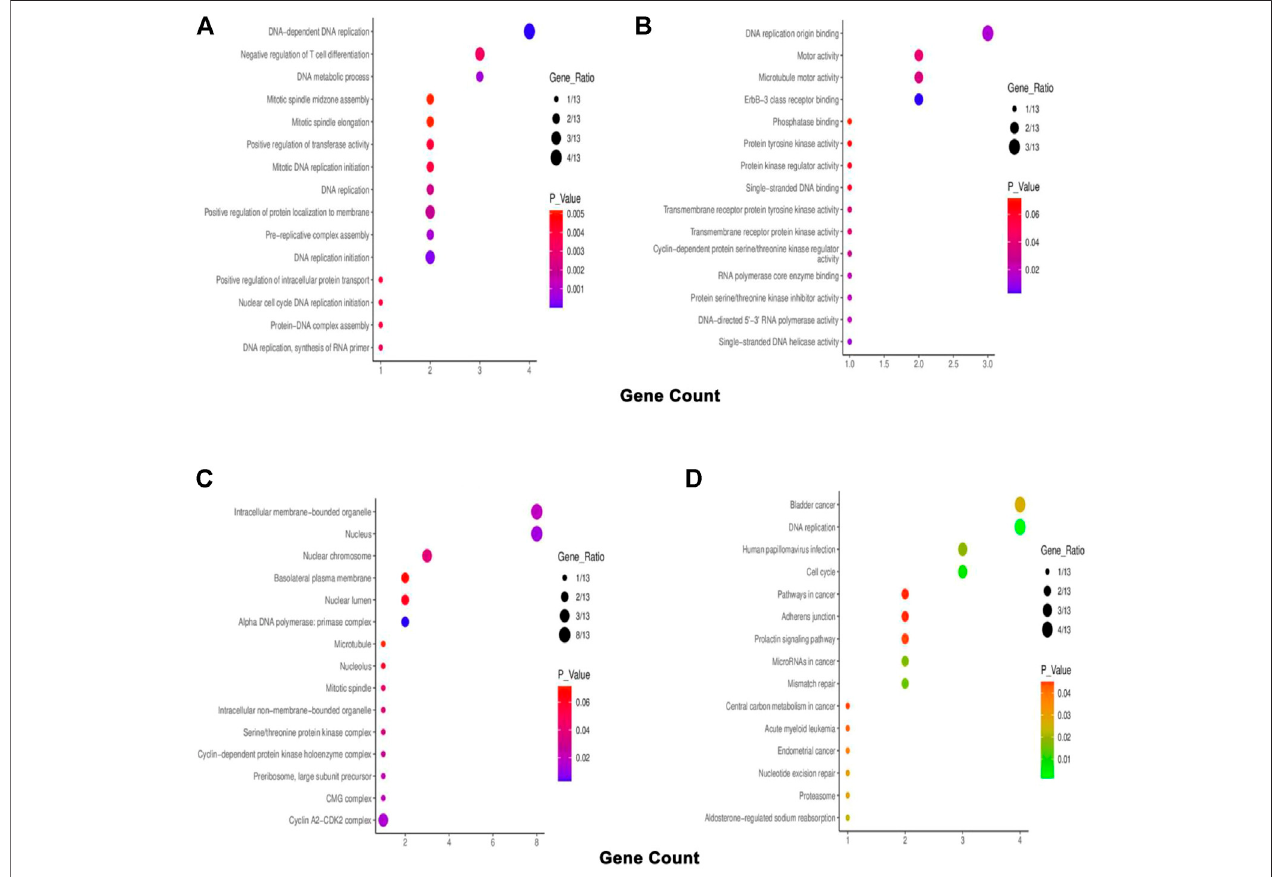
FIGURE 10 | Bubble plots representing the enriched gene ontology terms of the overlapping 13 neighbor genes of PSMC s in LUAD tissues: (A) biological processes, (B) molecular function, (C) cellular component, and (D) KEGG pathway.